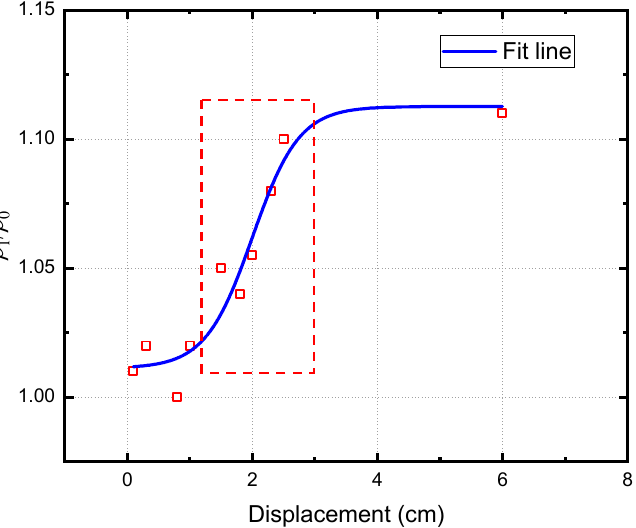
Figure 14. Relationship between the soil displacement and the density ratio ρ 1 / ρ 0 , where ρ 0 and ρ 1 were the initial and final densities after the DC tests on the modeled sandy